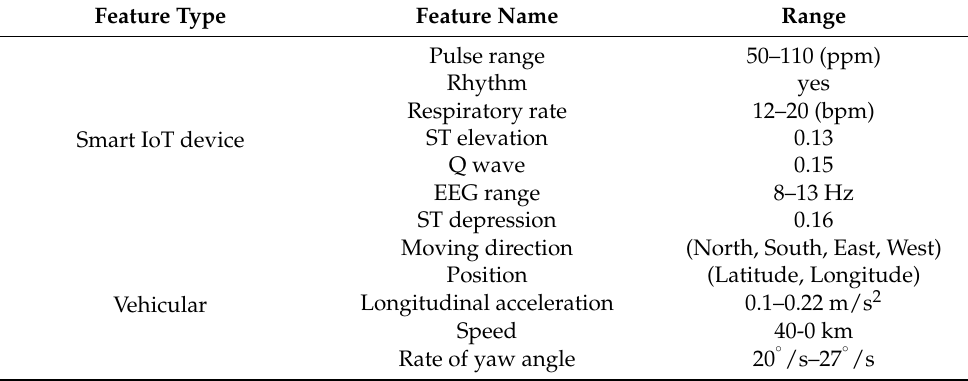
Table 2. Features considered for driver behavior analysis.